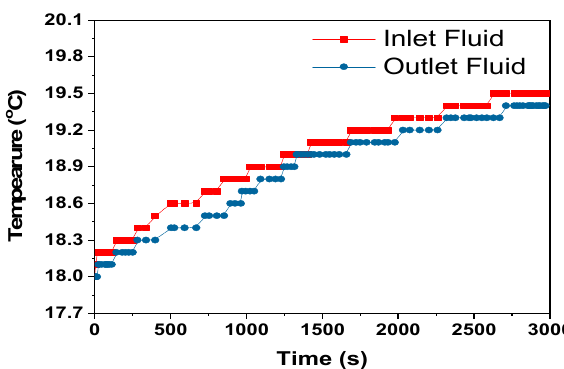
Figure 13. The coolant temperature variation measured at the inlet and outlet of the heat exchanger during the 1C wet discharge of the battery module.